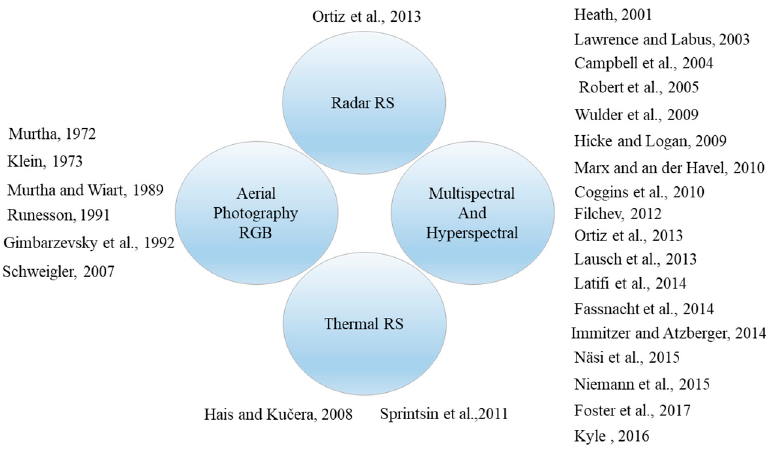
Figure 1. Studies that have used remote sensing data to attempt detecting bark beetle infestation at the green attack stage.